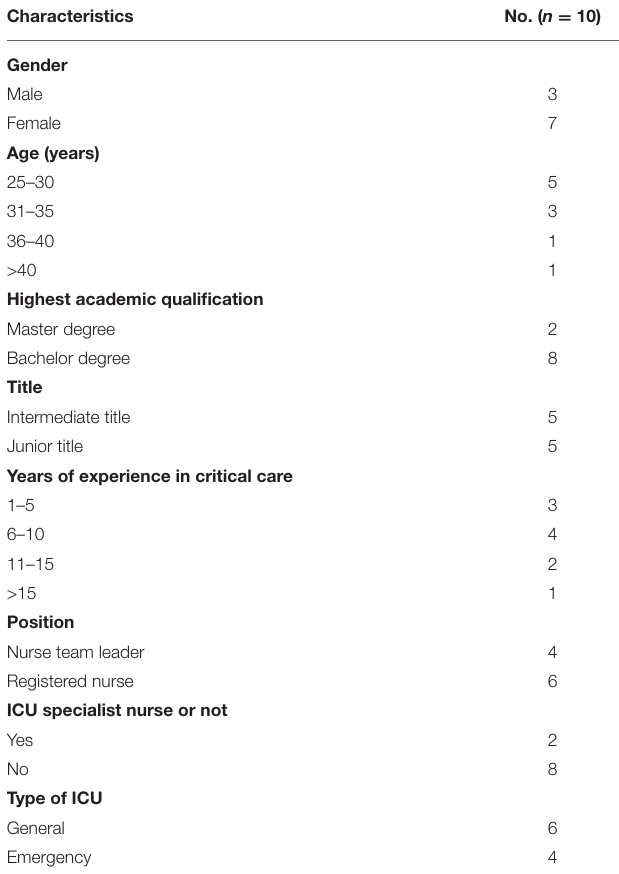
TABLE 1 | Participants’